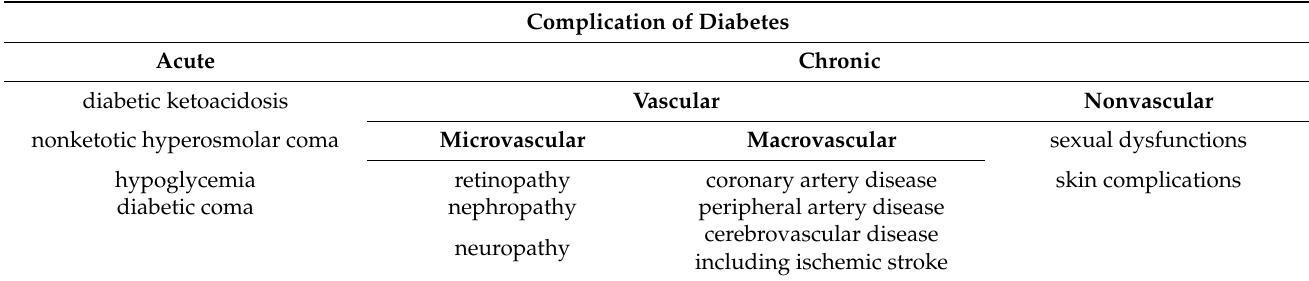
Table 1. Main complication of diabetes